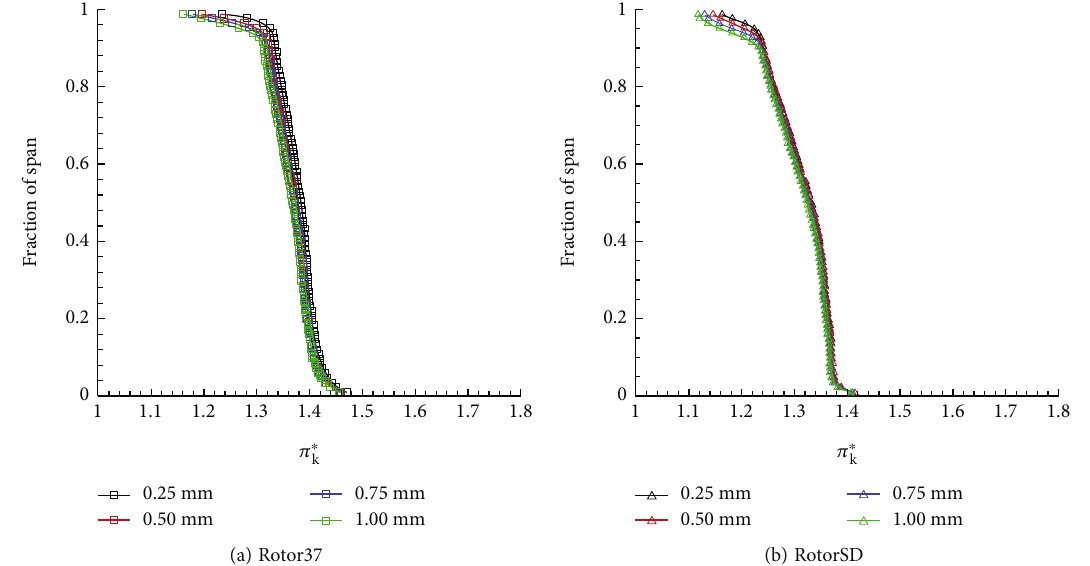
Figure 18: Distribution of the total pressure ratio along the span at 70% of the design